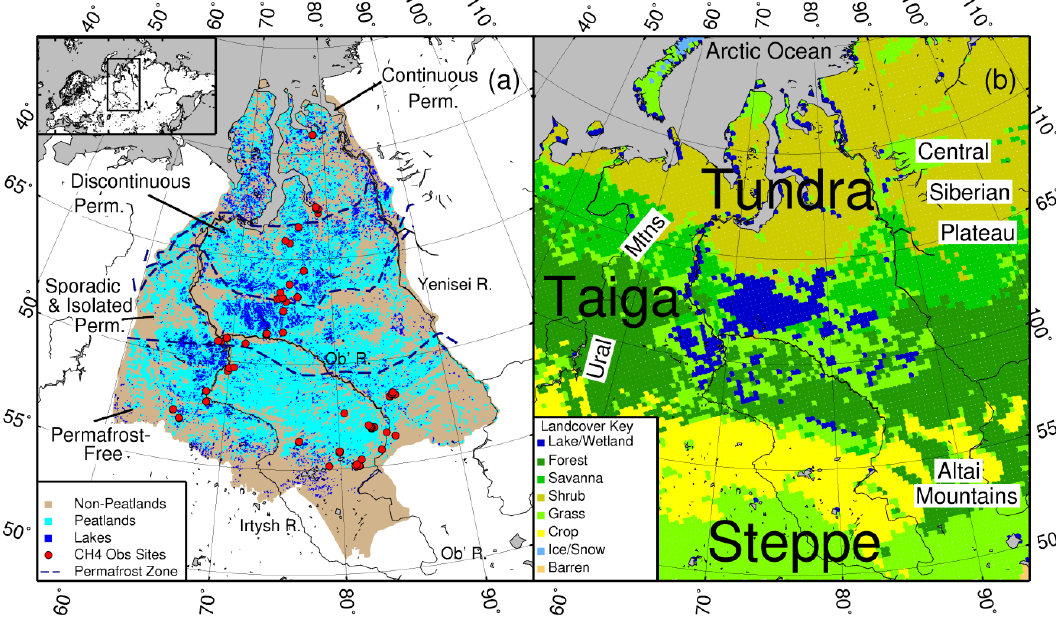
Figure 1. Map of the West Siberian Lowland (WSL). (a) Limits of domain (brown) and peatland distribution (cyan), taken from Sheng et al. (2004); lakes of area > 1km 2 (blue) taken from Lehner and Döll (2004); permafrost zone boundaries after Kremenetski et al. (2003); CH 4 sampling sites from Glagolev et al. (2011), denoted by red circles. (b) Dominant land cover at 25km derived from MODIS-MOD12Q1 500m land cover classification (Friedl et al.,